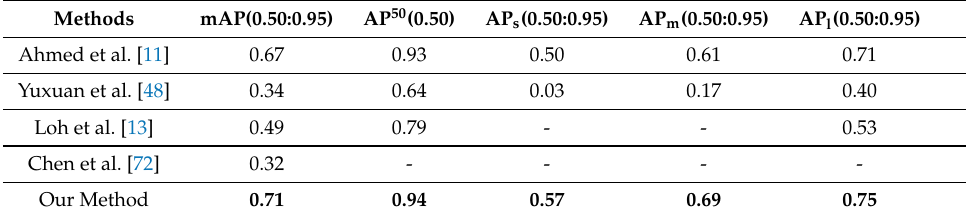
Table 1. Comparison between the proposed method and previous state-of-the-art results on the ExDark dataset. AP s denotes the average precision for a small area, whereas AP m represents the average precision for a medium area and AP l depicts the average precision for a large area. The IoU threshold is also defined in the table. The best results are in bold.